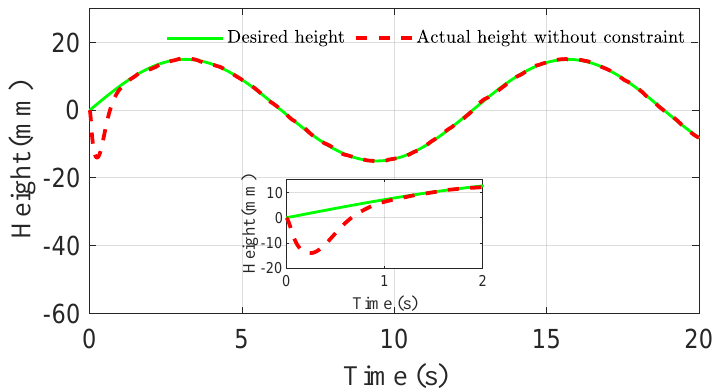
Figure 5. Height comparison of quarter vehicle with AAS in co-simulation.